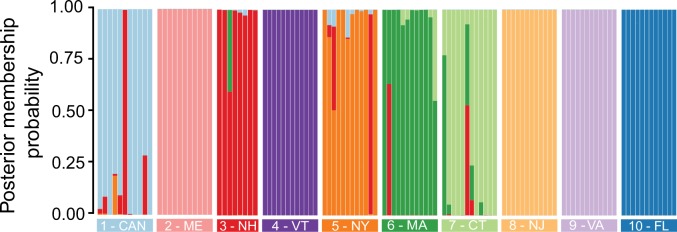
A genotype composition plot showing the posterior membership probability of mosquitoes following DAPC analysis.Individuals are grouped by the population. The majority of individuals are appropriately assigned to their respective populations.